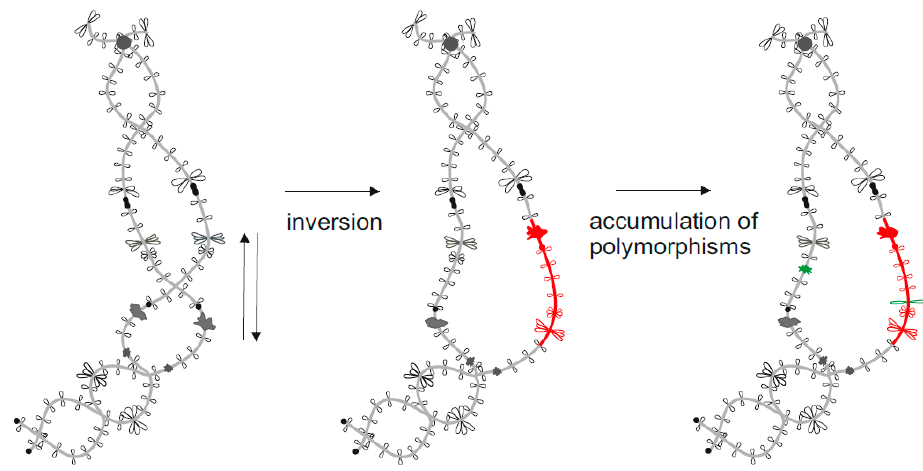
Figure 3. Example of lampbrush chromosome application to study chromosomal rearrangements. Inverted order of marker structures (special loops and granules) indicates the inversion of a chromosomal segment. Additional marker structures appear after accumulation of genetic polymorphisms in the absence of recombination.